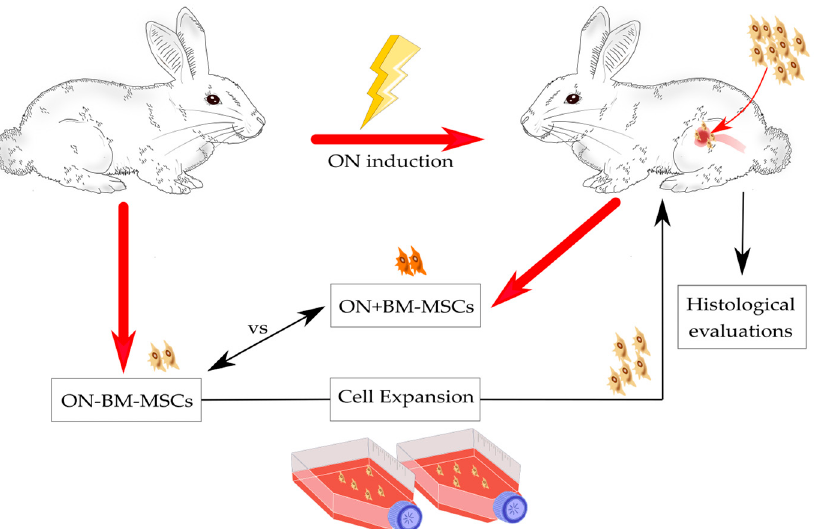
Figure 1. Overview of the experiments. Bone marrow (BM) was harvested from five rabbits and mesenchymal stromal/stem cells (MSCs) were isolated and expanded in vitro. Bilateral osteonecrosis (ON) damage was created in femoral heads (FHs), and after two weeks, BM was again harvested in order to isolate MSCs and compare cells before (ON-BM-MSCs) and after (ON+BM-MSCs) ON induction. In parallel, ON-BM-MSCs were implanted into the damaged FHs. Two weeks post-implantation, FHs were harvested and analyzed by histological assays to evaluate bone regeneration.